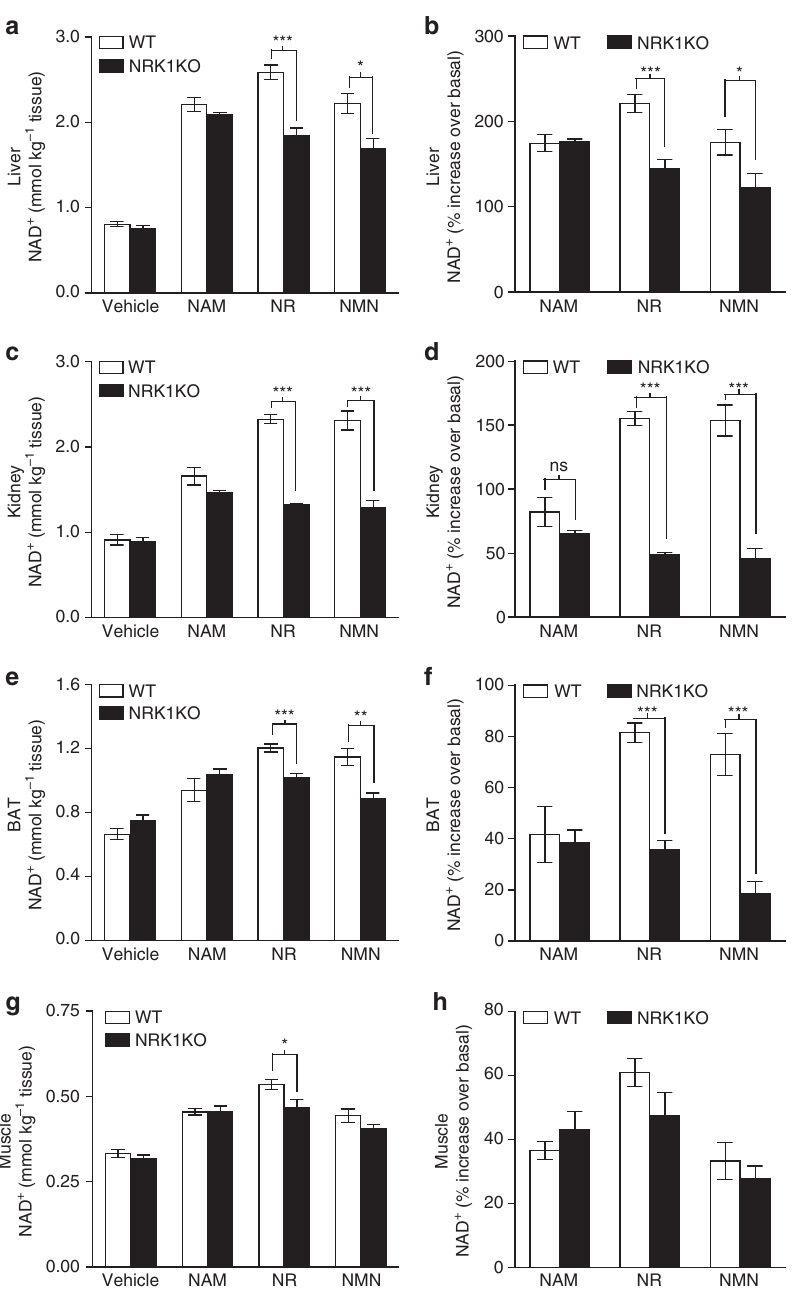
Figure 7 | NAD þ in vivo metabolism in NRK1KO mice. Five to six weeks old WT and NRK1KO male mice were IP injected with 500mgkg (cid:2) 1 of the indicated compounds. Then, liver, kidney, brown adipose (BAT) and skeletal muscle samples were collected after 1h, n ¼ 5 per group. NAD þ measurement in liver ( a ), total kidney extracts ( c ), BAT ( e ) and muscle ( g ) tissue. Percentage increase above basal NAD þ level in liver ( b ), kidney ( d ), BAT ( f ) and muscle ( h ) tissue upon treatments. Results shown are mean ± s.e.m., * P o 0.05, ** P o 0.01, *** P o 0.001 versus WT by two-sided unpaired T -test ( n ¼